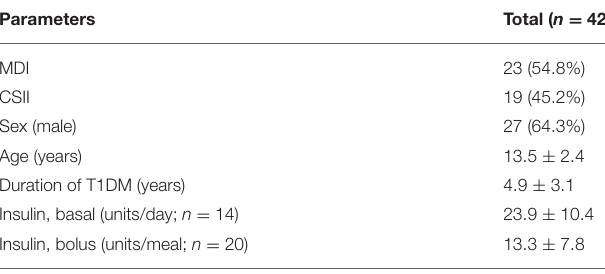
TABLE 1 | Baseline characteristics of the study cohort. Parameters